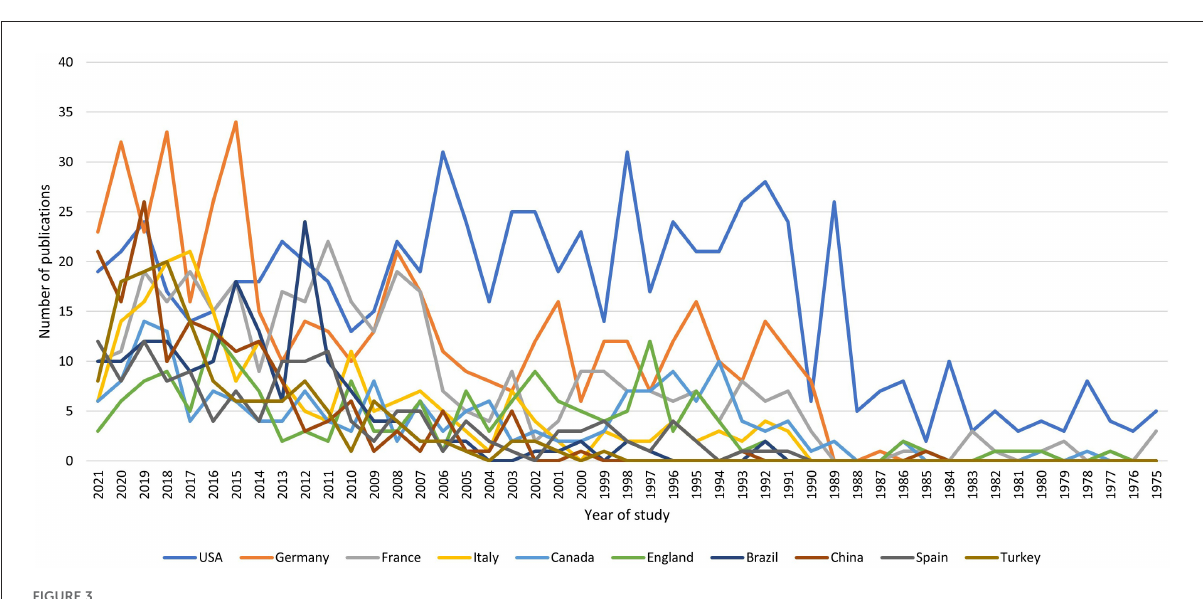
FIGURE3 Top 10 countries which published articles on occupational diseases over the past 46